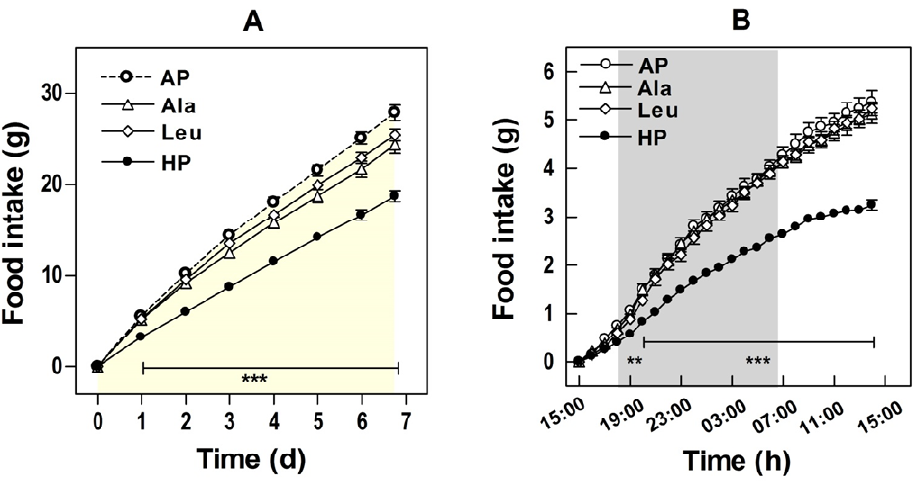
Figure 3. Food intake. Ten weeks old male C57BL/6 mice were fed for seven days ad libitum with experimental semisynthetic high-fat diets (20% w / w of fat) containing different protein and leucine and alanine concentrations. AP, adequate protein (10% w / w of whey protein); HP, high-protein (50% w / w of whey protein); Leu, AP supplemented with L -leucine corresponding to HP (+6% w/w L -leucine, 0.572 mole); Ala, AP supplemented with equimolar L -alanine (+4.5% w / w L -alanine, 0.572 mole). ( A ) Cumulative food intake during the whole feeding trial; ( B ) Food intake on the first day of dietary intervention. Values are means ± SEM. The shaded area refers to night (light off) period. Asterisks indicate significant differences from AP ( ** p < 0.01, *** p < 0.0001)